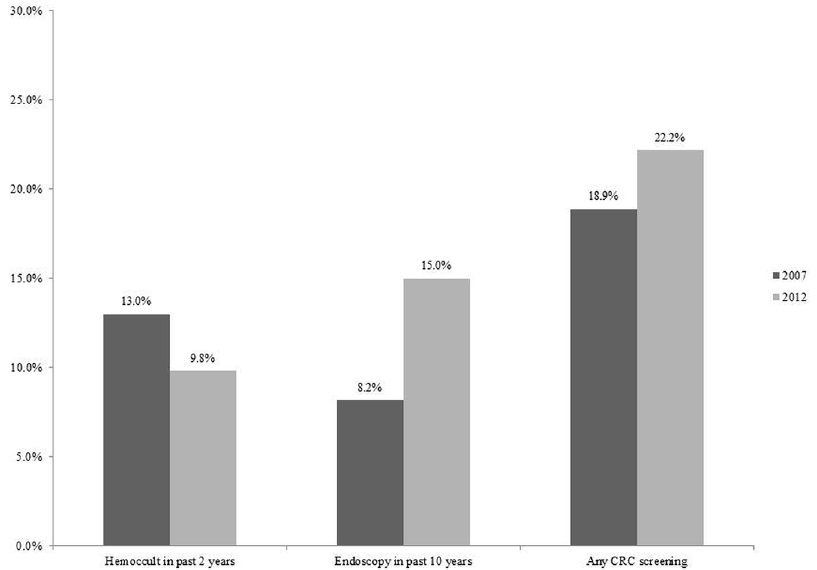
Fig 1. Colorectal Cancer Screening Weighted Prevalence among Respondents Aged 50 – 75 years of age from Swiss Health Interview Survey 2007 – 2012. Hemoccult in past 2 years 2007 vs 2012 (p- value = 0.002). Endoscopy in past 10 years 2007 vs 2012 (p-value < 0.001). Any CRC screening (Hemoccult in past 2 years or endoscopy in past 10 years or both) 2007 vs 2012 (p-value = 0.036). P-values are